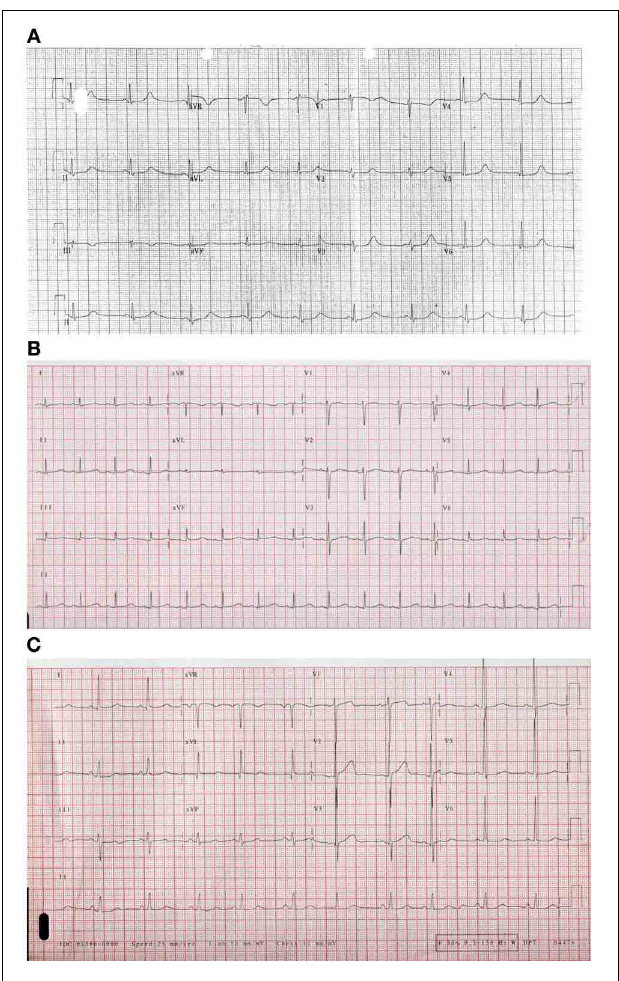
FIGURE 1 | Examples of ECGs for different forms of Long QT Syndrome (A). Long QT 1 (B) LQT2 illustrating bifid T wave morphology (C) . Long QT3 illustrating flat isoelectric segment with small symmetrical T wave particularly in lead